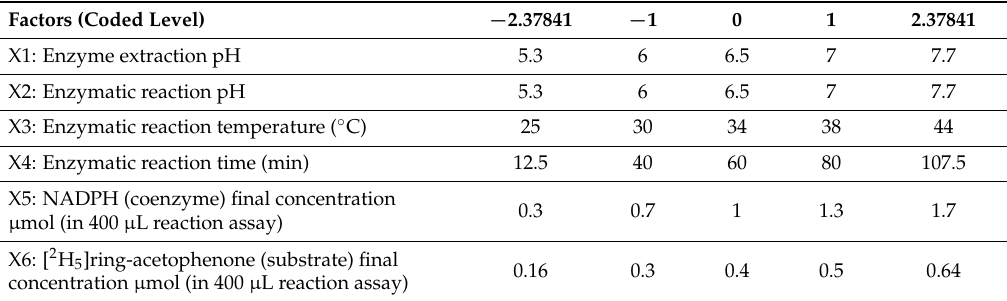
Table 1. Factors and levels of response surface methodology.